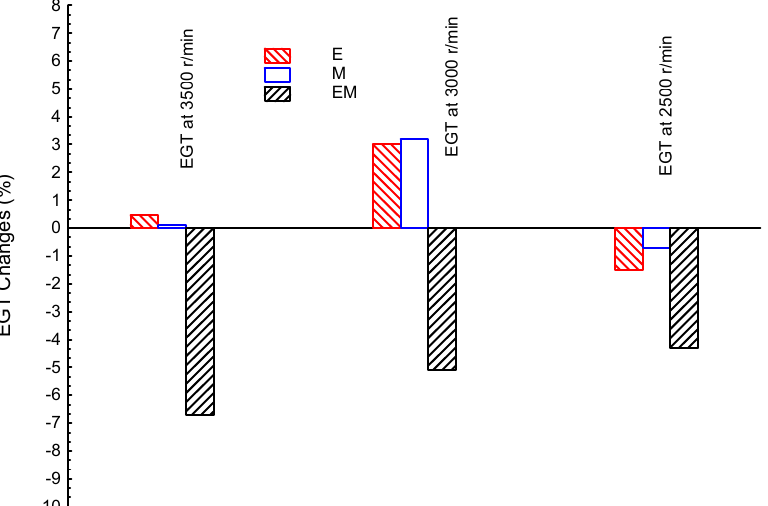
Figure 3. Exhaust gas temperature (EGT) at three different engine speeds (3500, 3000, and 2500 r/min) for blended fuels of bio-ethanol–bio-methanol–gasoline (EM), bio-ethanol–gasoline (E), and bio-methanol–gasoline (M); gasoline is the reference line.